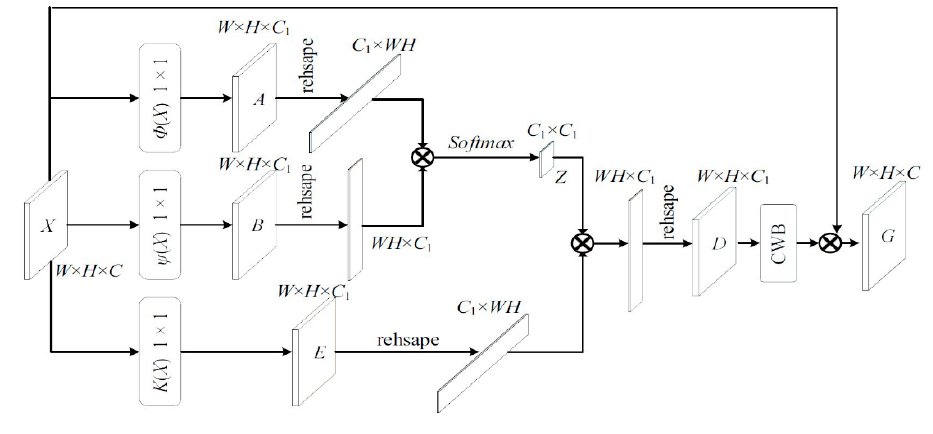
Figure 6. Spatial and context attention